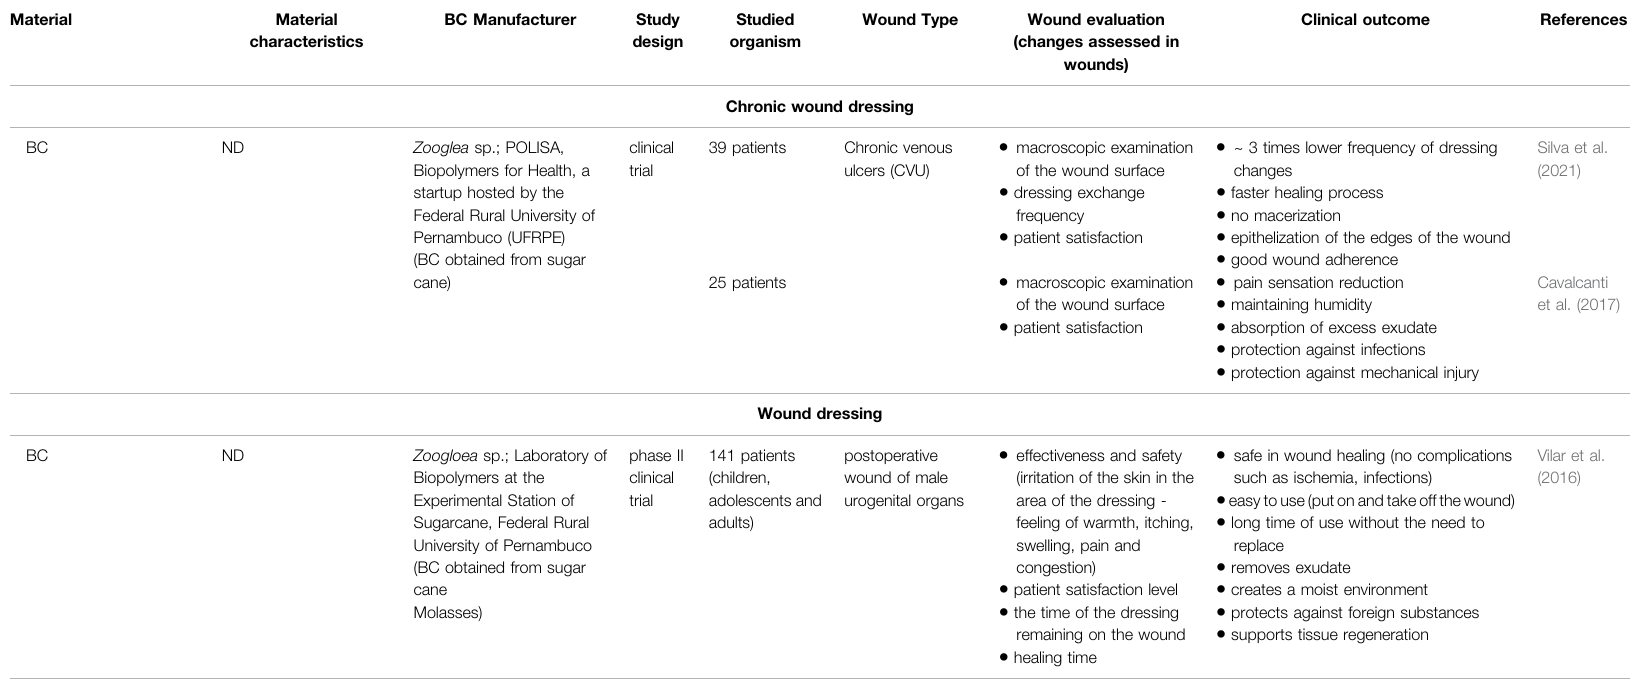
TABLE 3 | ( Continued ) Characteristics of BC and BC composites used in wound care — results of clinical